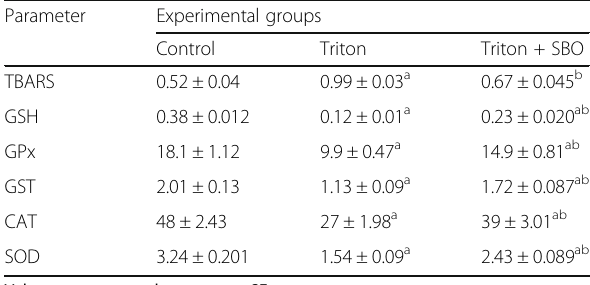
Table 3 The effect of soybean oil (SBO), Triton WR-1339, and their combination on liver and brain antioxidant enzymes in male rats compared to a control